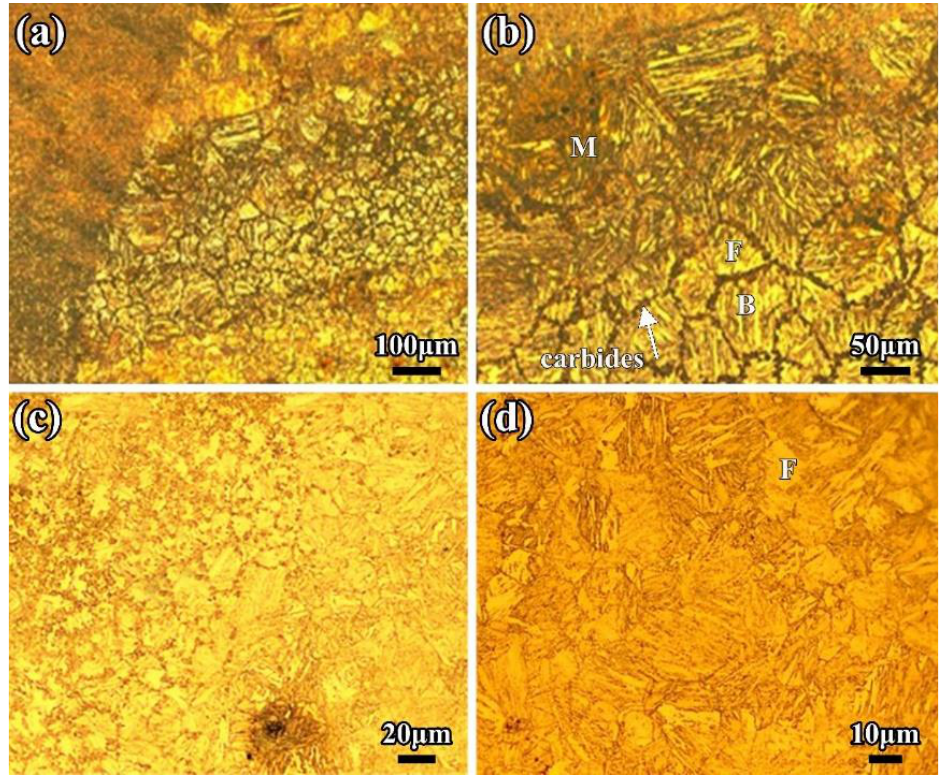
Figure 9. Microstructure of SMAW joint ( a ) Macro-photo in weld metal ( b ) Bainite ferrite in weld